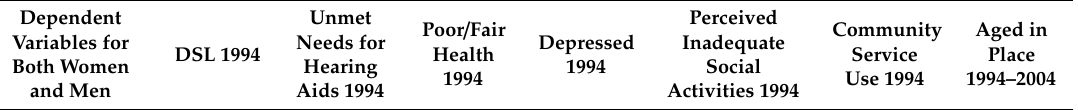
Table 10. Multivariate regression results on DSL prevalence and its associated outcomes in 1994, all